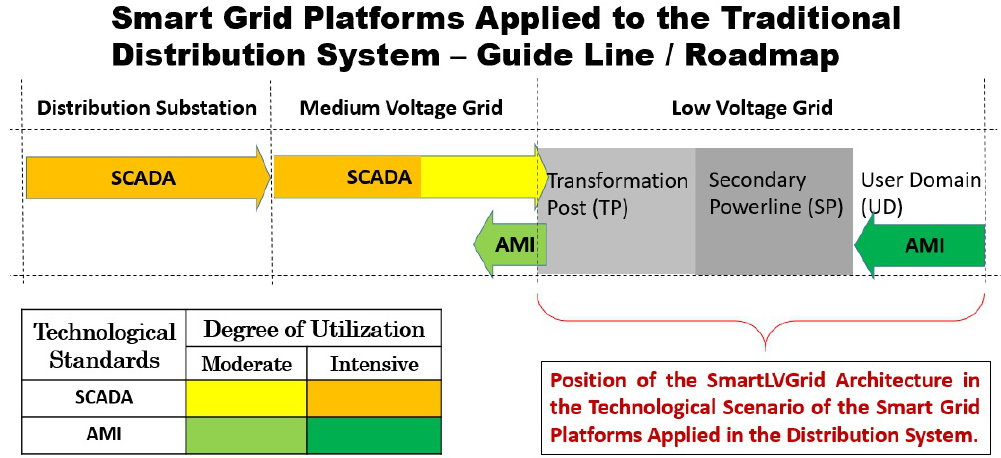
Figure 1. Evolution scenario (unplanned) of the primary technological standards in the implementation of the smart grid paradigm in the traditional distribution